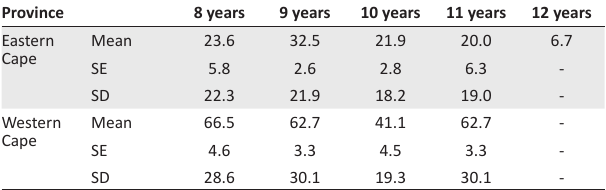
FIGURE 1: Age distribution of Grade 3 learners per province. TABLE 7: Receptive knowledge of high-frequency words per province and age group ( %